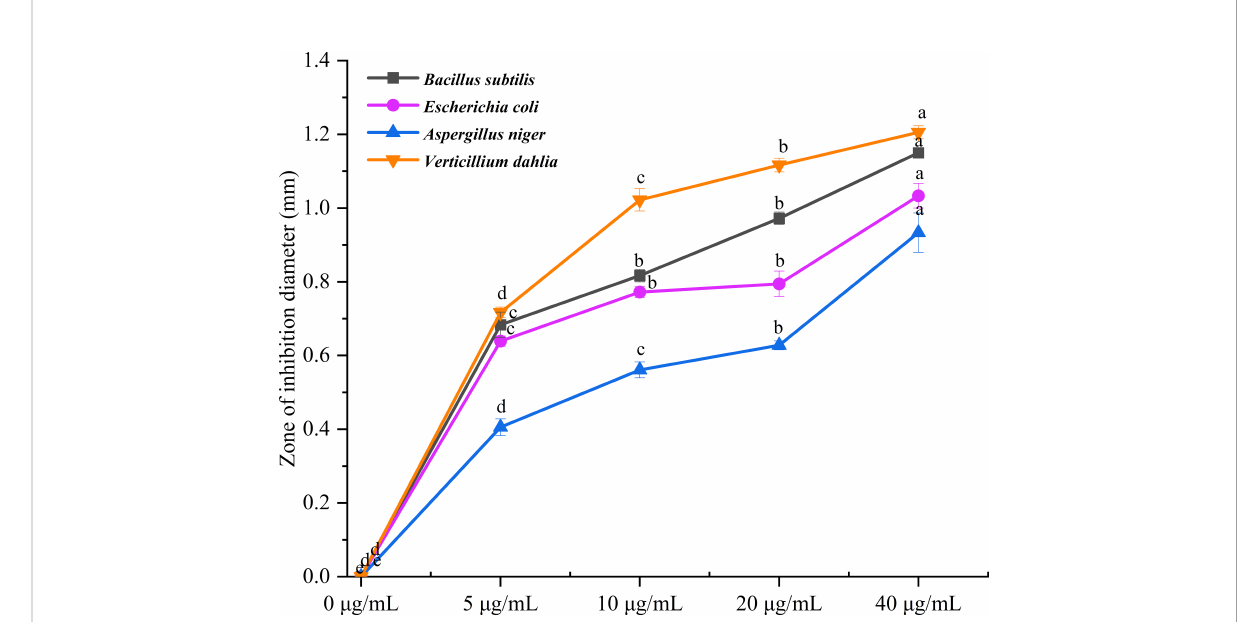
FIGURE 4 Antimicrobial activity of A. tibetica EO. Different letters indicated signi fi cant differences ( P< 0.05) level according to Fisher ’ s LSD test.